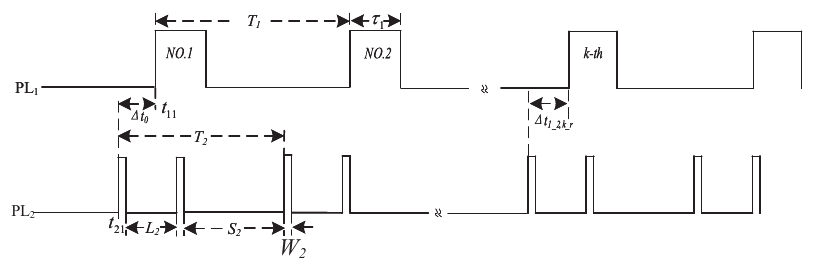
Figure 4. The baseband signal of SSR